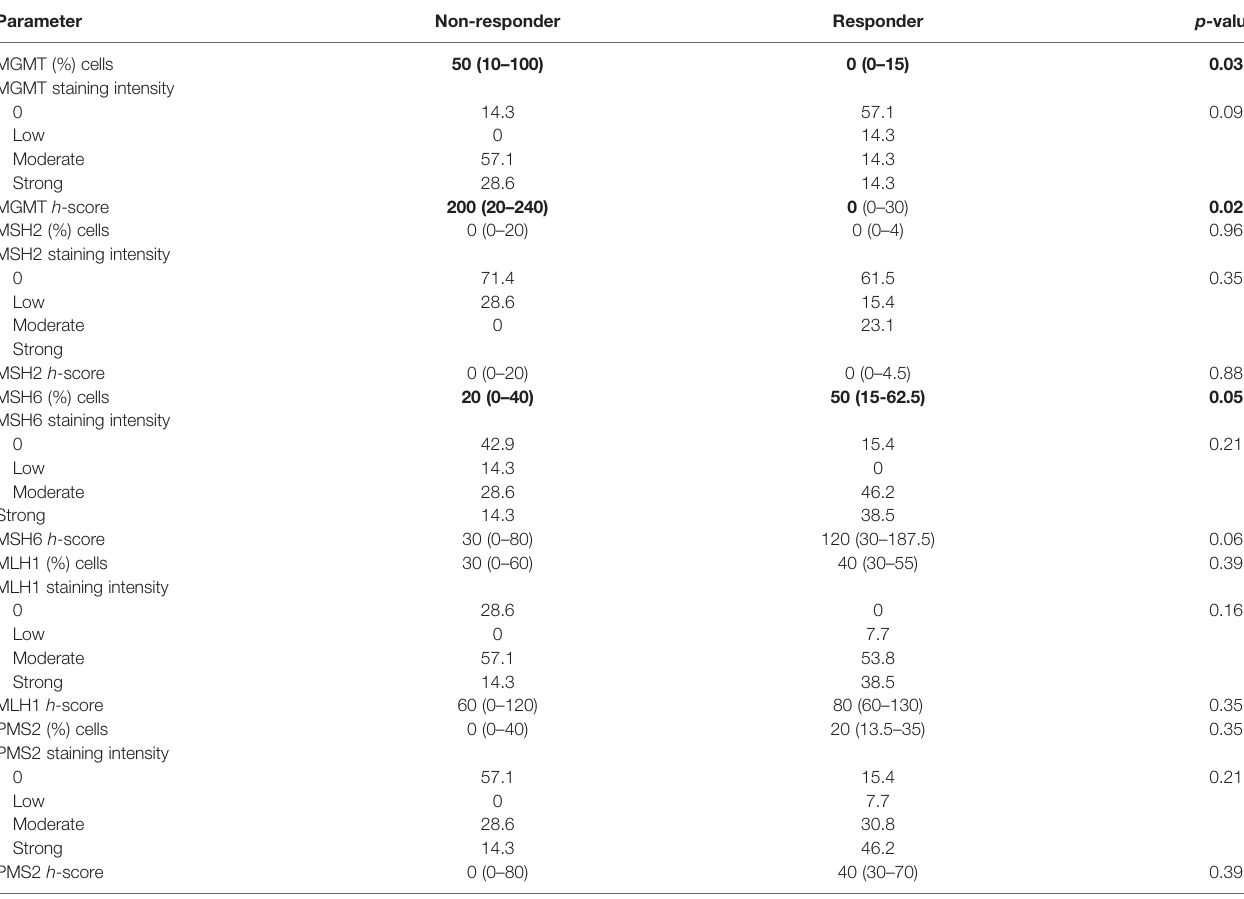
TABLE 4 | Comparative histopathological and immunohistochemical parameters between responders and non-responders.